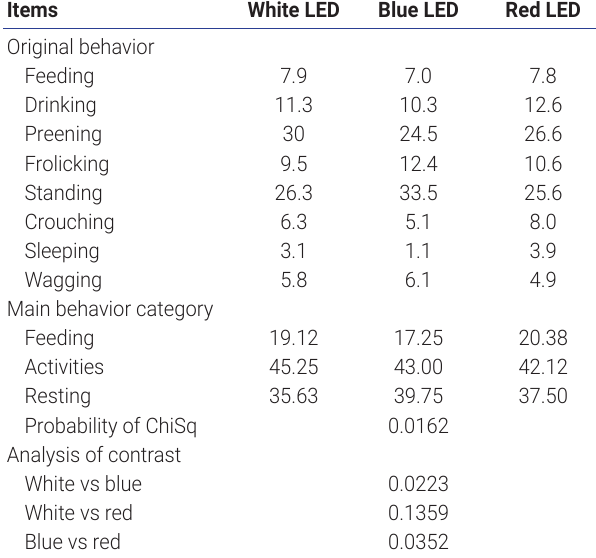
Table 10. The results of Brown Tsaiya ducks behavior pattern in dif- ferent treatment groups (%) Items White